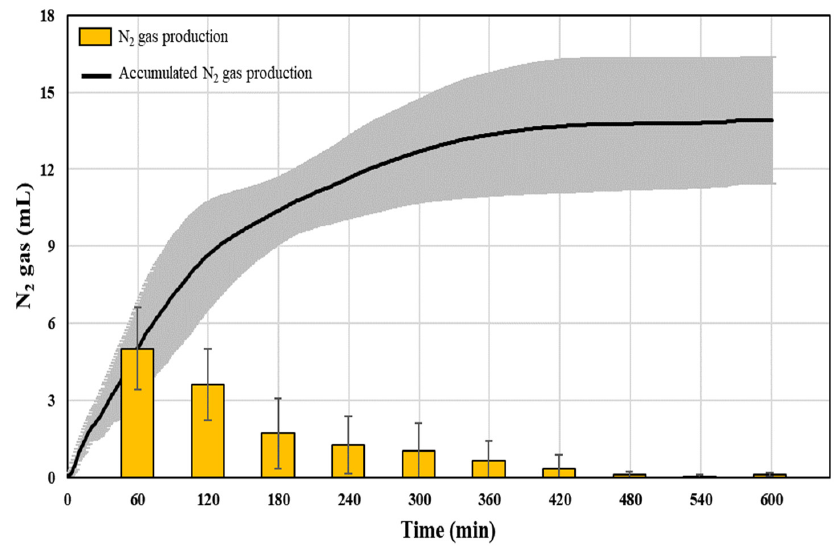
Figure 2. Changes in nitrogen gas amount (bar) as a function of time (min) and accumulated nitrogen gas amount (line) during the total reaction time. The grey area indicates the standard deviation for accumulated N 2 gas production.